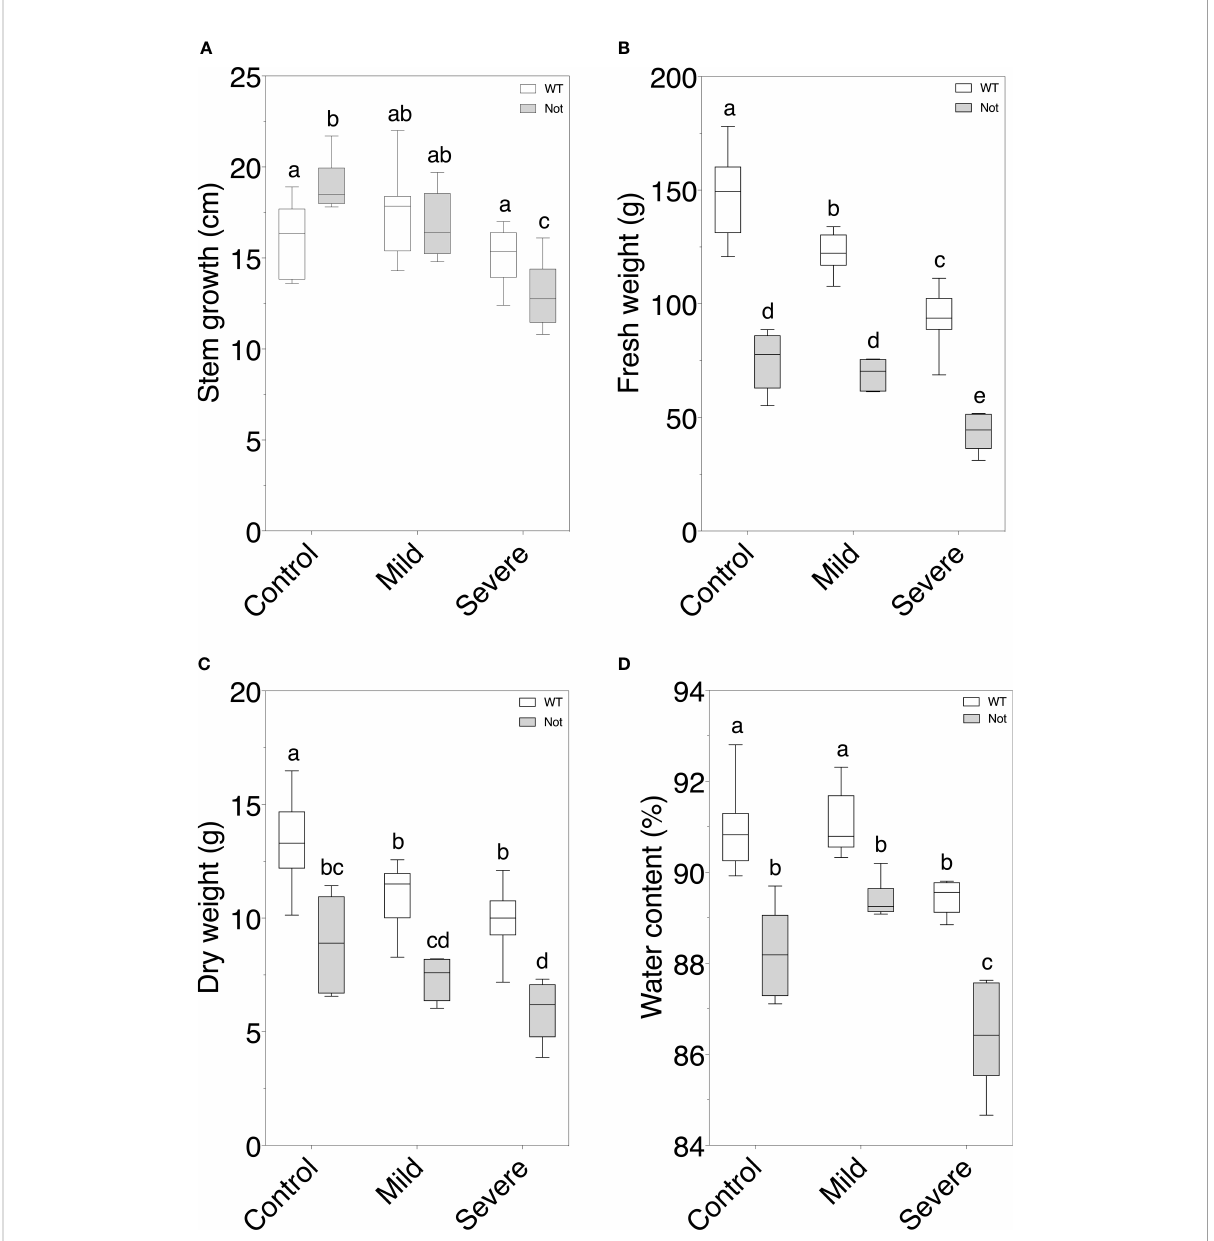
FIGURE 2 Assessment of plant growth parameters in wild-type and notabilis plants during salt stress. (A) Stem length increase over the course of 7 days (n = 10), (B) fresh weight (n = 10), (C) dry weight (n = 10) and (D) water content (n = 10) after 7 days under control (EC of 2.5 dS/m), mild (EC of 5 dS/m; [NaCl] = 47 mM) and severe (EC of 10 dS/m; [NaCl] = 94 mM) salt stress conditions for the wild-type (white) and notabilis (gray). Signi fi cant differences are indicated with different letters ( a =